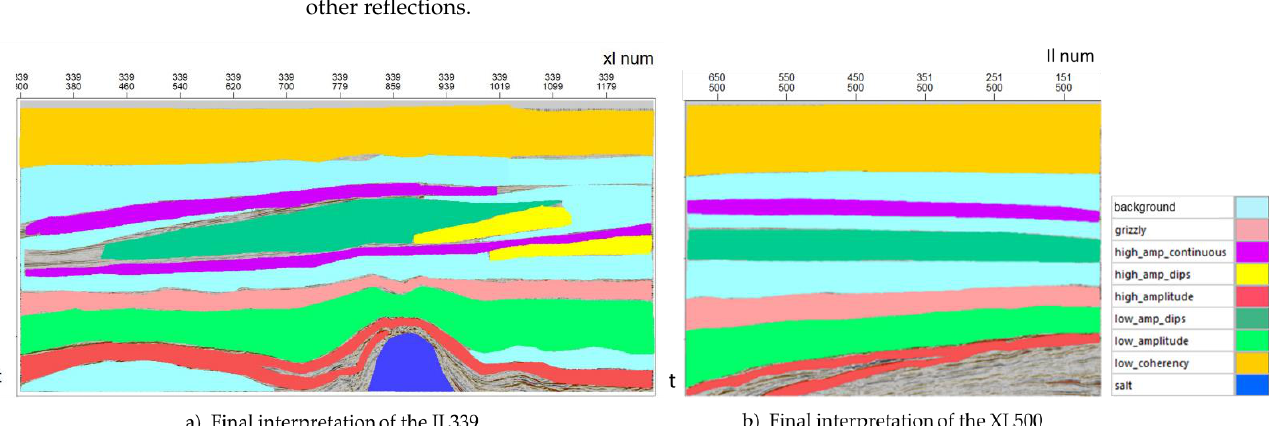
Figure 3. Final interpretation of the IL339 ( a ) and the XL500 ( b ) used as input data for the algorithms. The unlabeled parts were either labeled as background facies or were not taken into account in the training dataset, depending on the algorithm. In the test dataset, unlabeled samples were ignored.